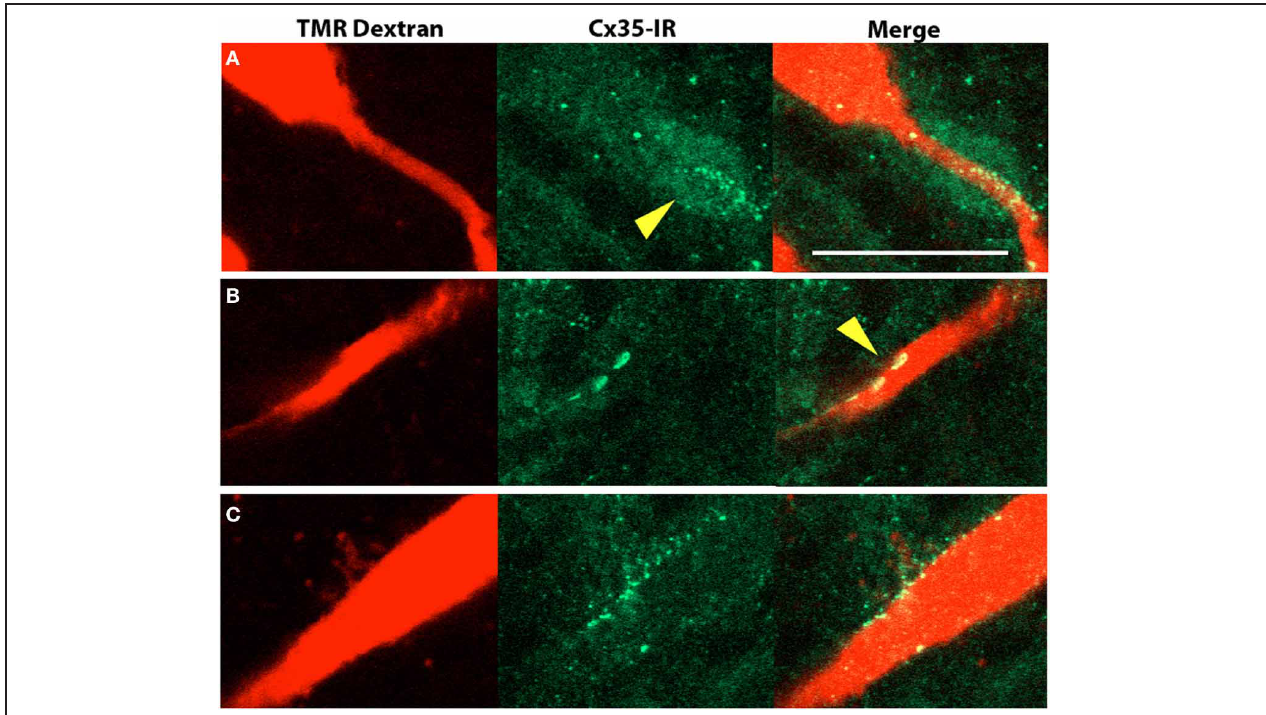
FIGURE 6 | Cx35 immunoreactivity in Mauthner neurons of 6dpf larvae. The left panels show retrograde labeling of a Mauthner neuron with tetra-methyl rhodamine dextran (TMR dextran, red). The middle panels show Cx35 immunoreactivity in green and the right panels show merge of the two channels. All images are single optical sections taken at a z-spacing of